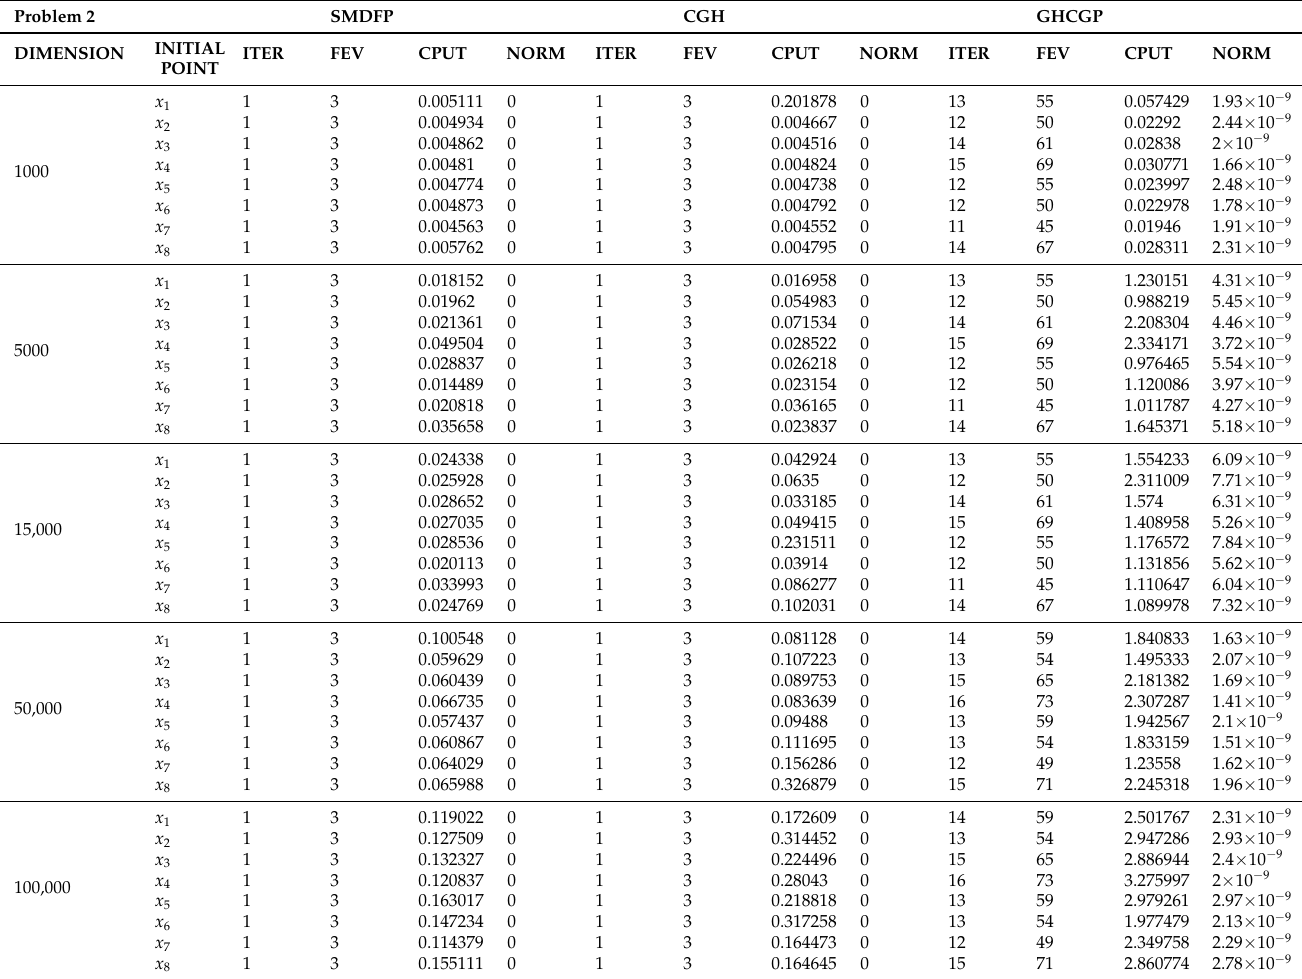
Table 2. Numerical comparison of the SMDFP, CGH [61], and GHCGP [62] methods.